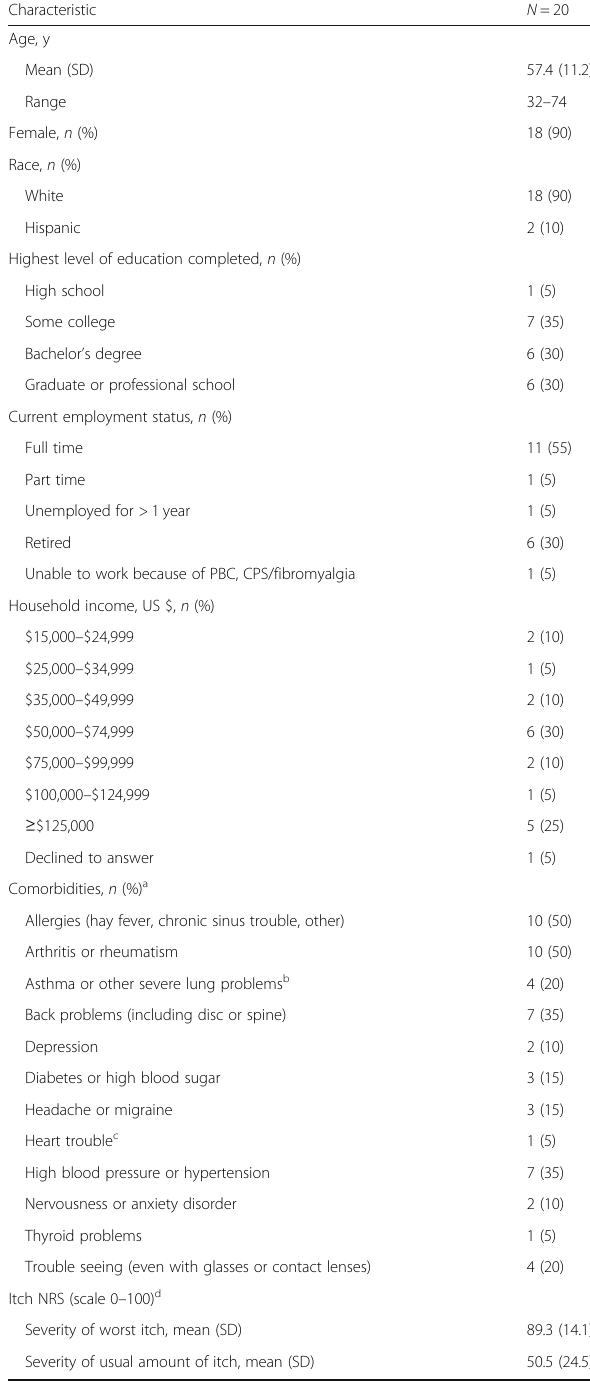
Table 1 Participant demographic and disease